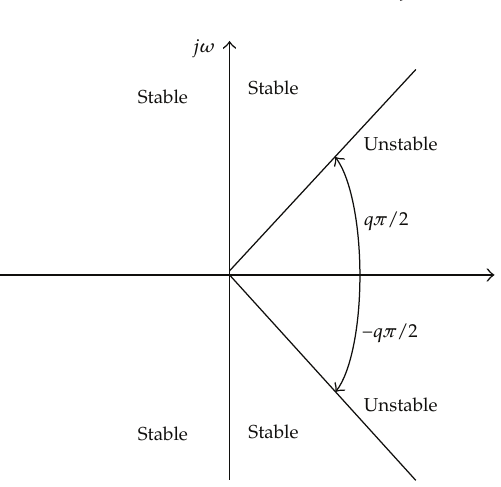
Figure 1: Stability region of fractional-order